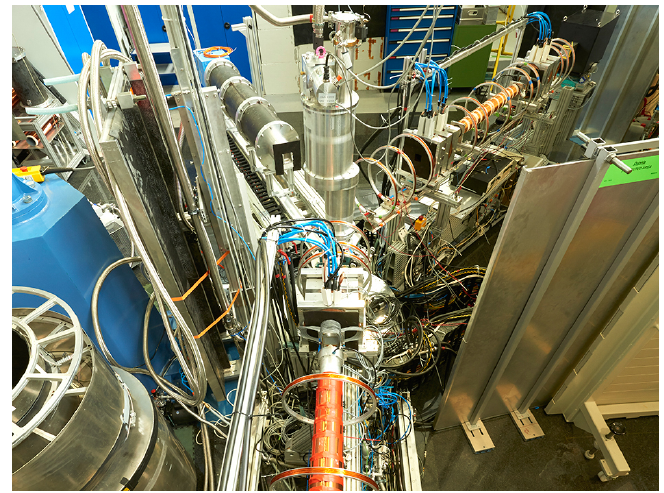
Figure 1: Instrument RESEDA (Copyright by W. Schürmann,